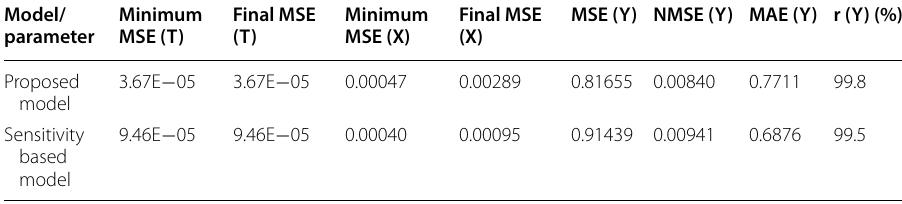
Table 3 Performance analysis between proposed ANN Model and sensitivity model Model/ Minimum Final MSE parameter MSE (T)